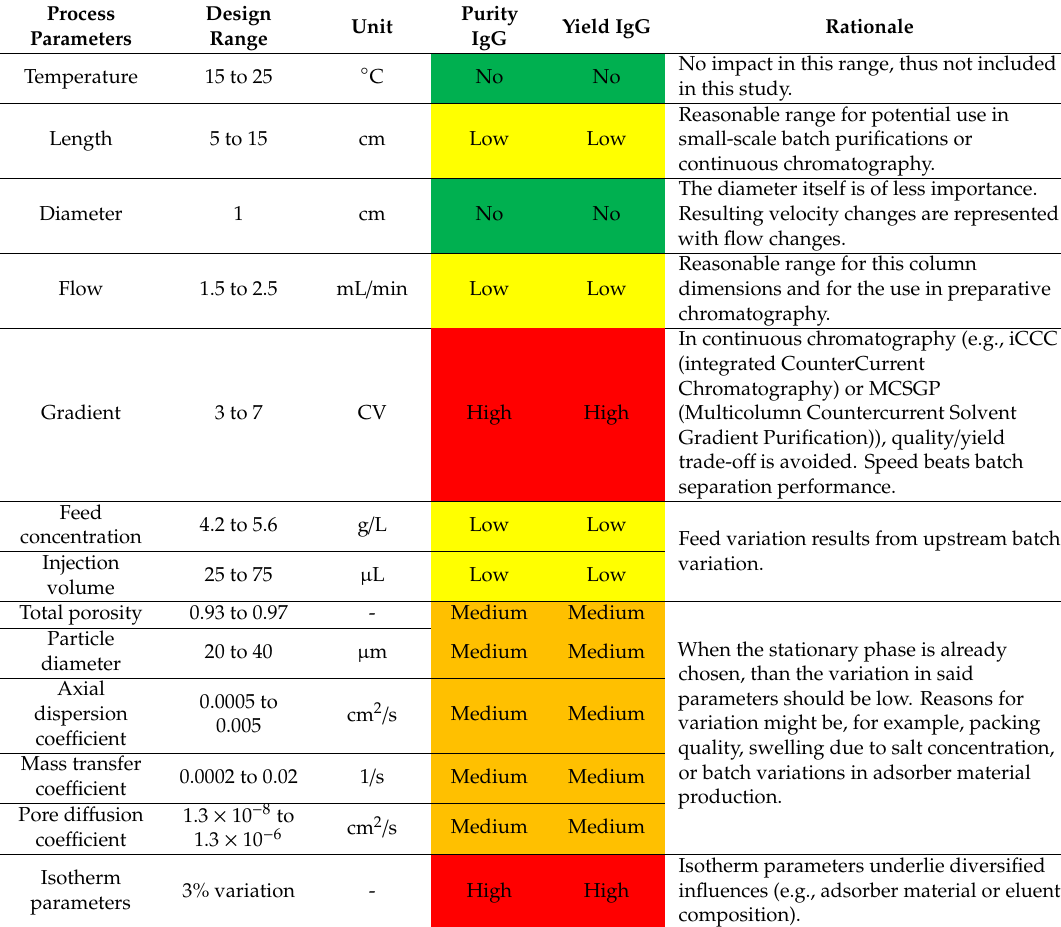
Table 1. Process and model parameters, their design range, and the expected impact on IgG purity and yield. Green—no impact; yellow—low impact; orange—medium impact; red—high impact. Process Design Purity Unit Yield IgG Rationale Parameters Range IgG No impact in this range, thus not included Temperature 15 to 25 ◦ C No No in this study. Reasonable range for potential use in Length 5 to 15 cm Low Low small-scale batch purifications or continuous chromatography. The diameter itself is of less importance. cm No No Resulting velocity changes are represented with flow changes. Reasonable range for this column Low dimensions and for the use in preparative chromatography. In continuous chromatography (e.g., iCCC (integrated CounterCurrent Chromatography) or MCSGP High High (Multicolumn Countercurrent Solvent Gradient Purification)), quality / yield trade-o ff is avoided. Speed beats batch separation performance. Low Feed variation results from upstream batch variation.Injection